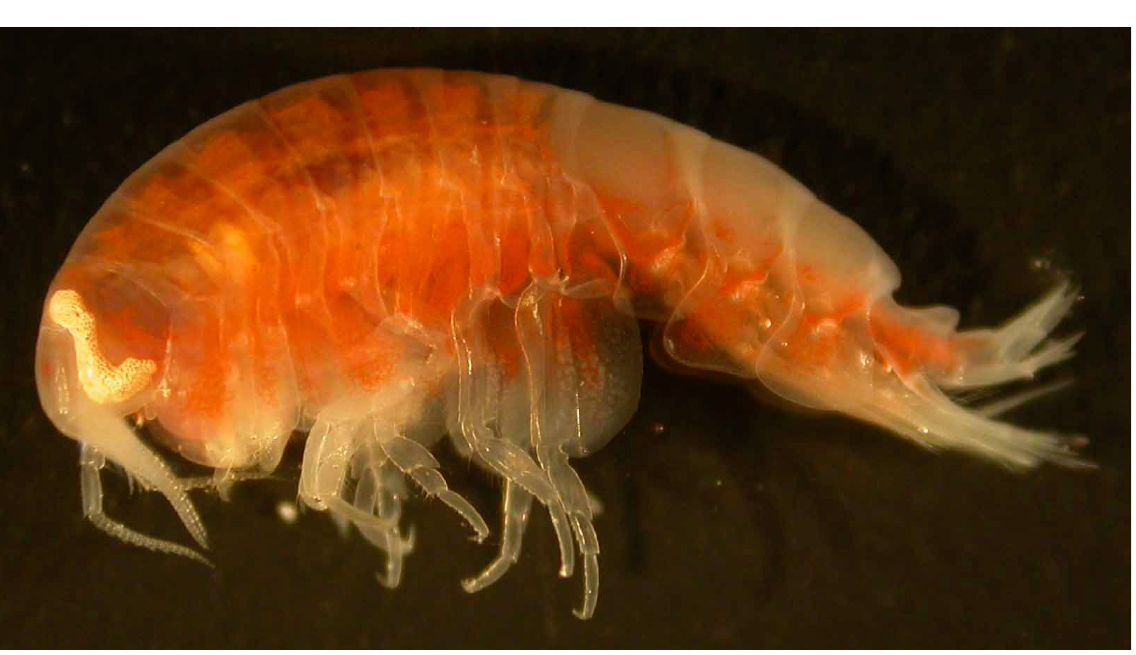
Fig. 18. Abyssorchomene scotianensis (Andres, 1983). Habitus, ♂, size unrecorded (specimen not isolated) (RBINS I.G. 31.070), RV Polarstern ANT XXIII-8 (IPY-CAML), station PS69-706-7, Weddell Sea, off East Peninsula, Larsen B, 65°27′ S, 61°27′ W, 828 m, 15–17 January 2007 (photo taken by Cédric d’Udekem d’Acoz, permission